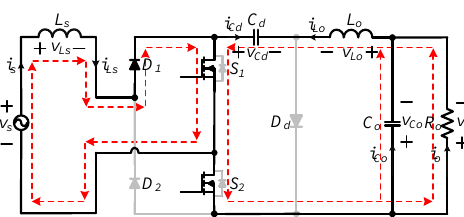
Figure 5. Equivalent circuit of the bridgeless Cuk converter in State 1 during positive half line cycle.